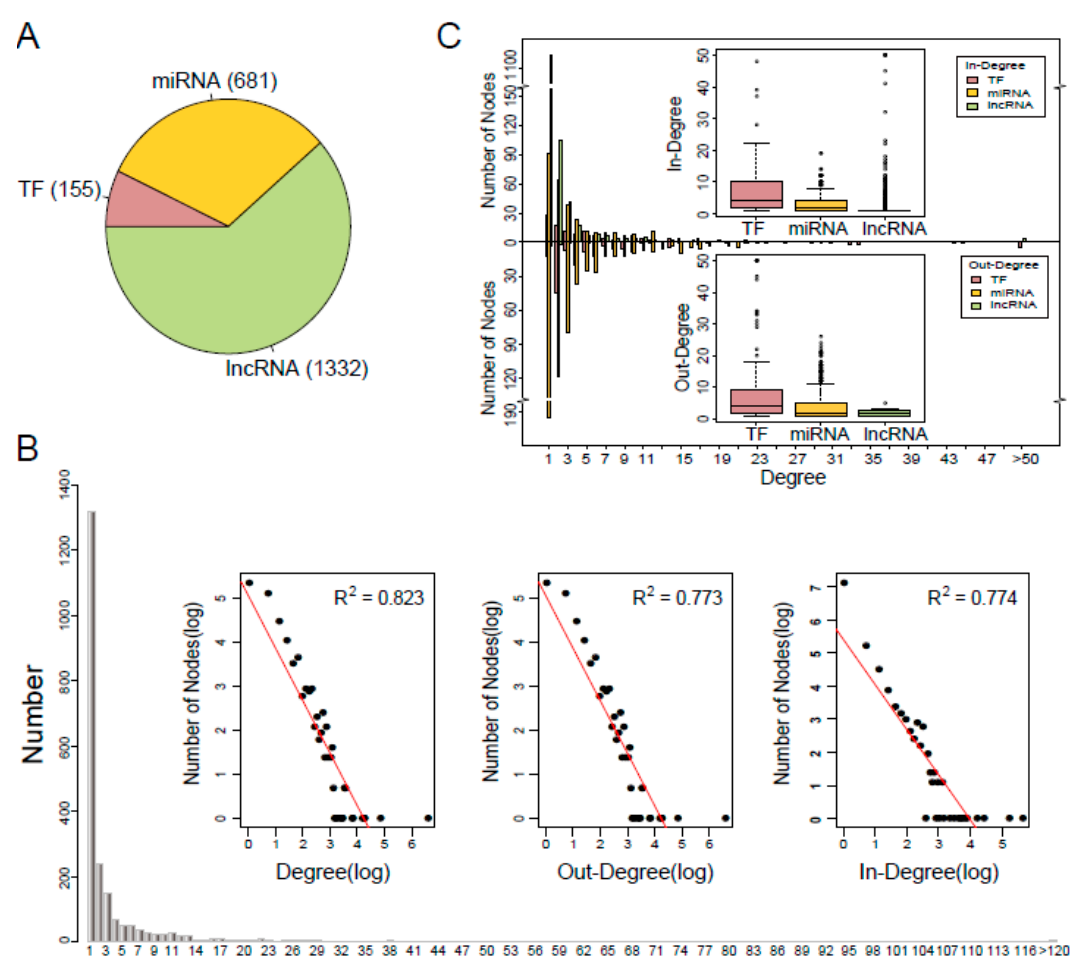
Figure 1. Characteristics of the TFs and ncRNAs coordinated regulatory (TNCR) network. ( A ) Proportion of transcription factor (TF), microRNA (miRNA) and long non-coding RNA (lncRNA) in the TNCR network. ( B ) Degree distribution of all nodes in the TNCR network and the log-log plots for the degree, out-degree and in-degree distributions of all nodes. ( C ) In-degree and out-degree distributions of TFs, miRNAs and lncRNAs in the TNCR network.